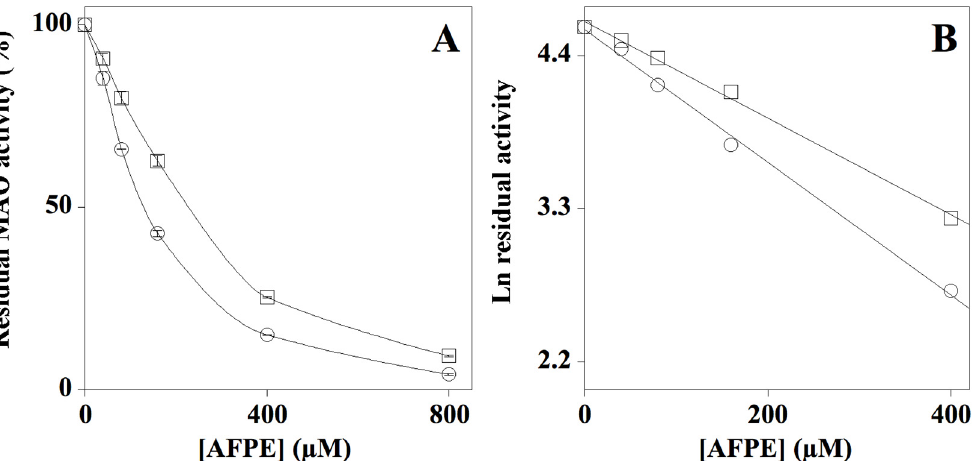
Figure 2. Effect of AFPE on MAO-A and MAO-B activity. ( A ) The MAO-A (circle) and MAO-B (square) enzyme activity was assayed in the absence or presence of the indicated amounts of AFPE. NB. 100 µM AFPE in the reaction mixture corresponds to 23 mg of apple flesh/mL. ( B ) Data were analyzed according to first order behavior, and the IC 50 values were calculated from the slope of the linear regression (r 2 = 0.998 for MAO-A and MAO-B).